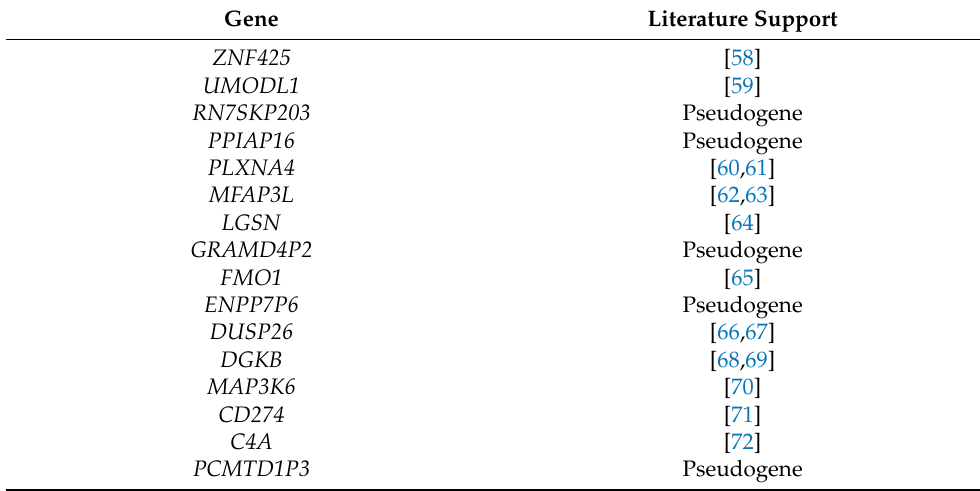
Table 2. Top Risk Increasing Genes Identified by TCGA-READ Cox model: List of the top risk increasing genes identified by our Cox model on the TCGA-READ